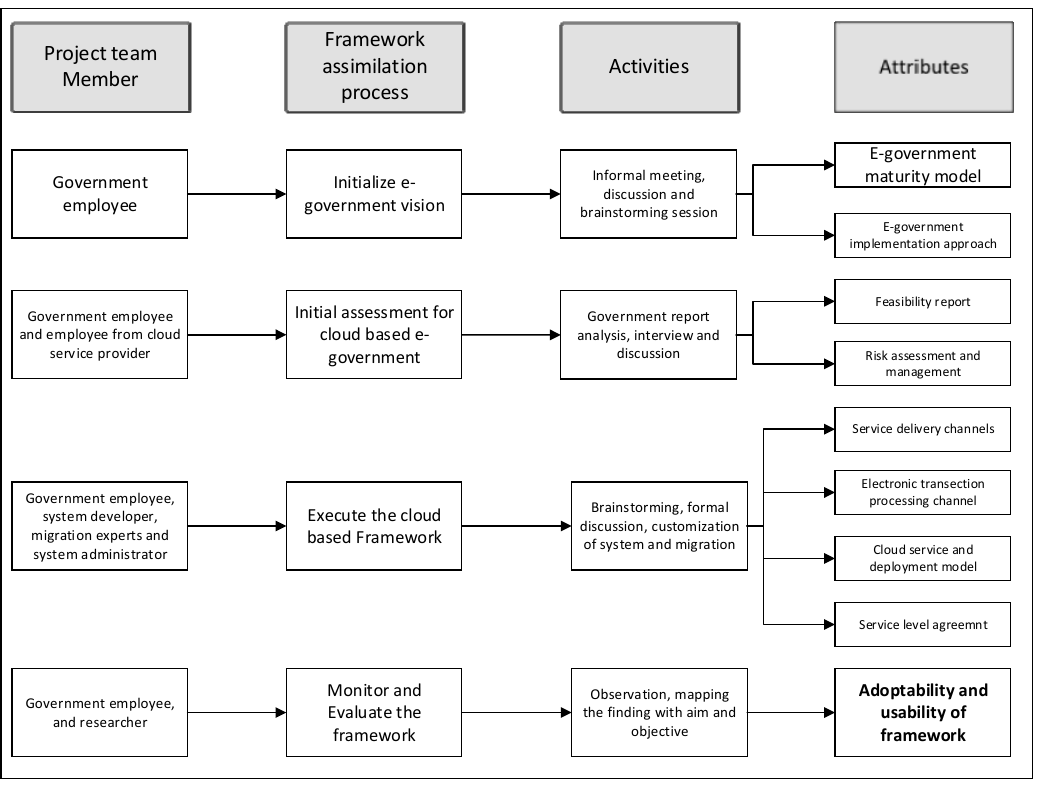
Figure 6 Case study design. Figure 6. Case study design.